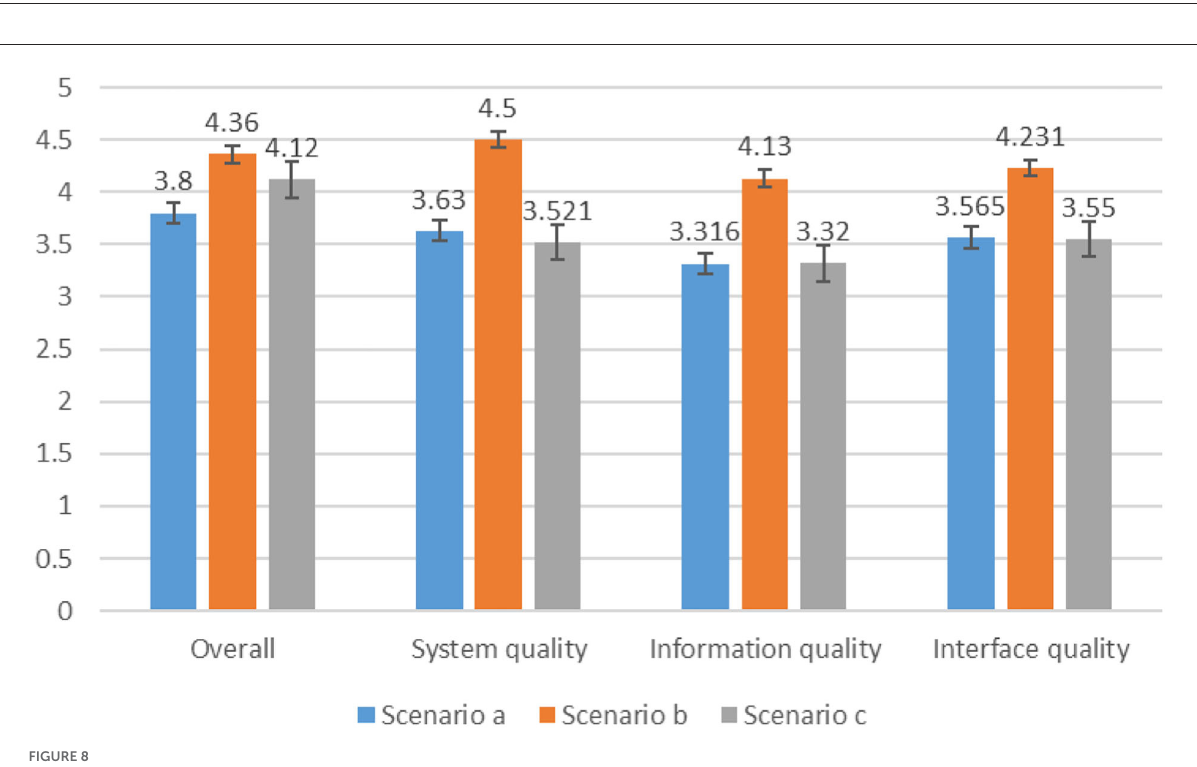
FIGURE8 PSSUQ evaluation scores for the three